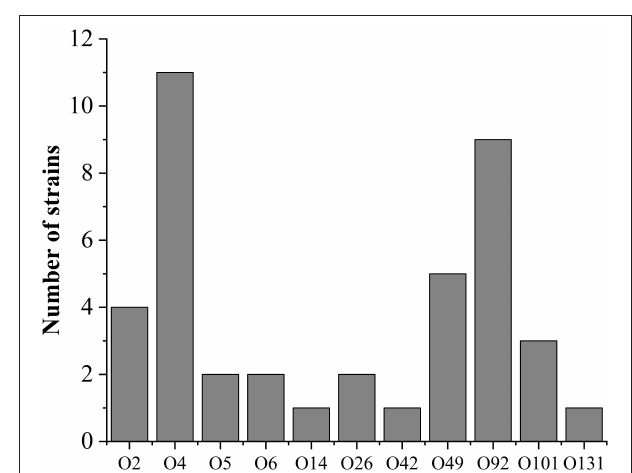
FIGURE 1 | Results of serotype detection of pathogenic E. coli isolates.